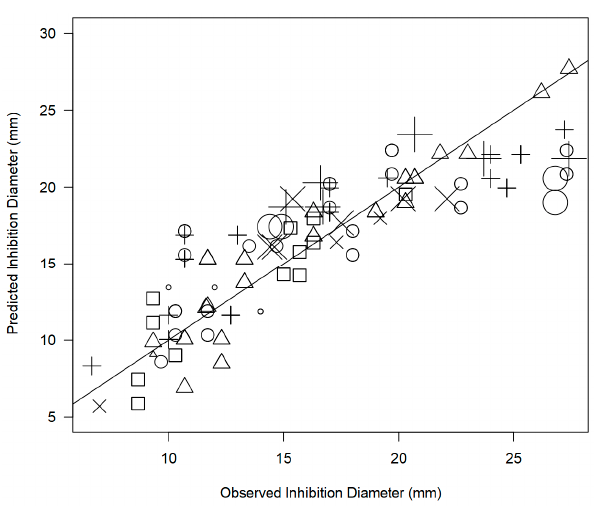
Figure 2. Scatter plot depicting inhibitory effects of extracts derived from Origanum ( n = 145), Syzygium aromaticum ( n = 10), and Citrus ( n = 7) plants against predicted values generated by the meta-regression model (R 2 = 0.860), with 45 ◦ reference line. Symbols represent different bacterial strains: □ = C. jejuni , ○ = L. monocytogenes , ∆ = S. aureus , + = Salmonella , × = STEC; marker size corresponds to the sample size of the respective study.